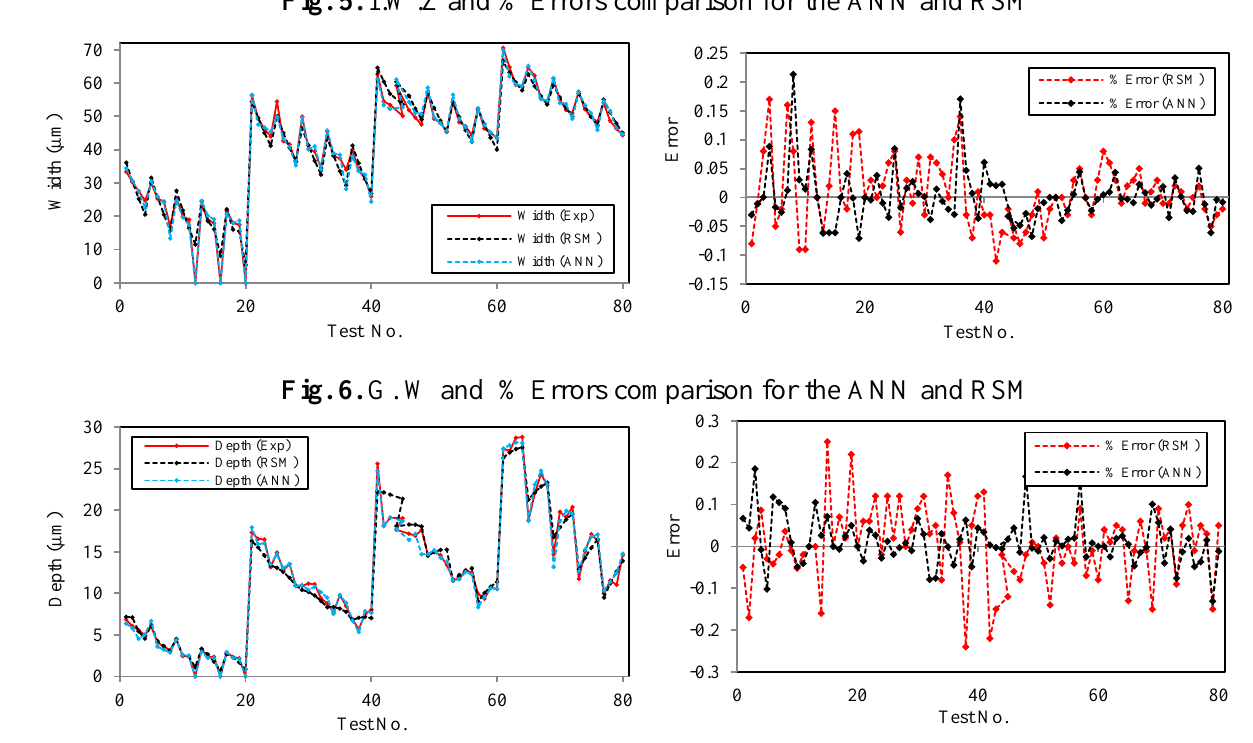
Fig. 7. G. D and % Errors comparison for the ANN and